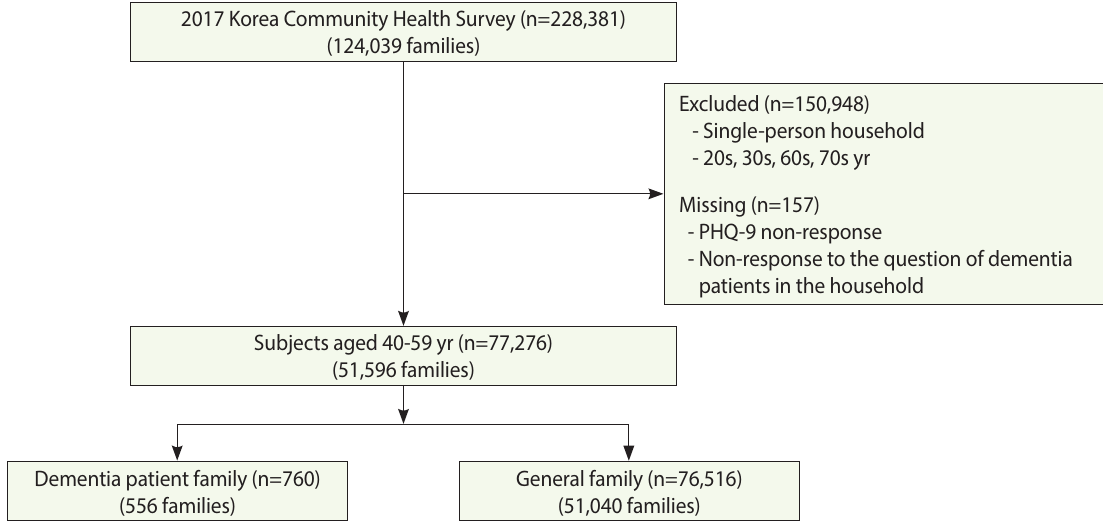
Figure 1. Flow chart of this study. PHQ-9, Patient Health